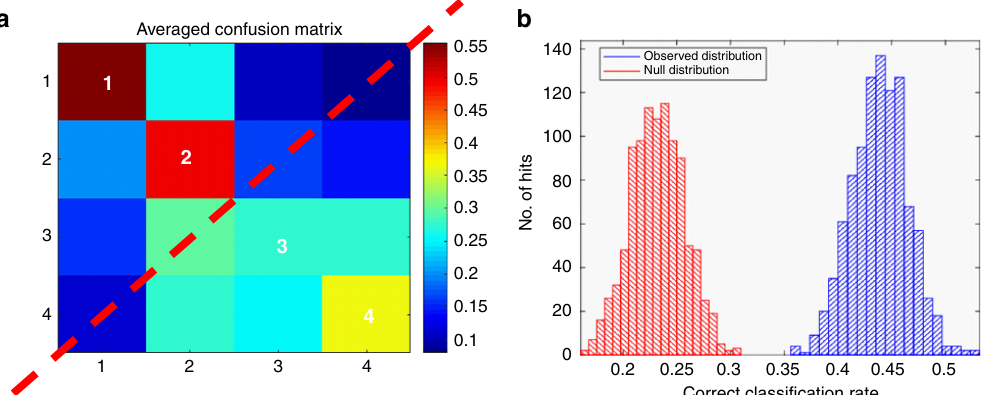
Fig. 3 RUSBoost-CART analysis of samples binned over the frailty index. a Machine learning based Random Under Sampling boosting Classi fi cation and Regression Tree analyses on ( + ) mode UHPLC-MS data supporting correct sample strati fi cation over frailty index distribution. Confusion Matrix indicates a clear separation between >0.2 and <0.2 on the frailty index and thus good model prediction. b Null-distribution classi fi cation rate (red frequency histogram) supporting machine learning results (blue frequency histogram) and, indicating the groupings in the confusion matrix are correctly classi fi ed. Source data are provided as a Source Data fi